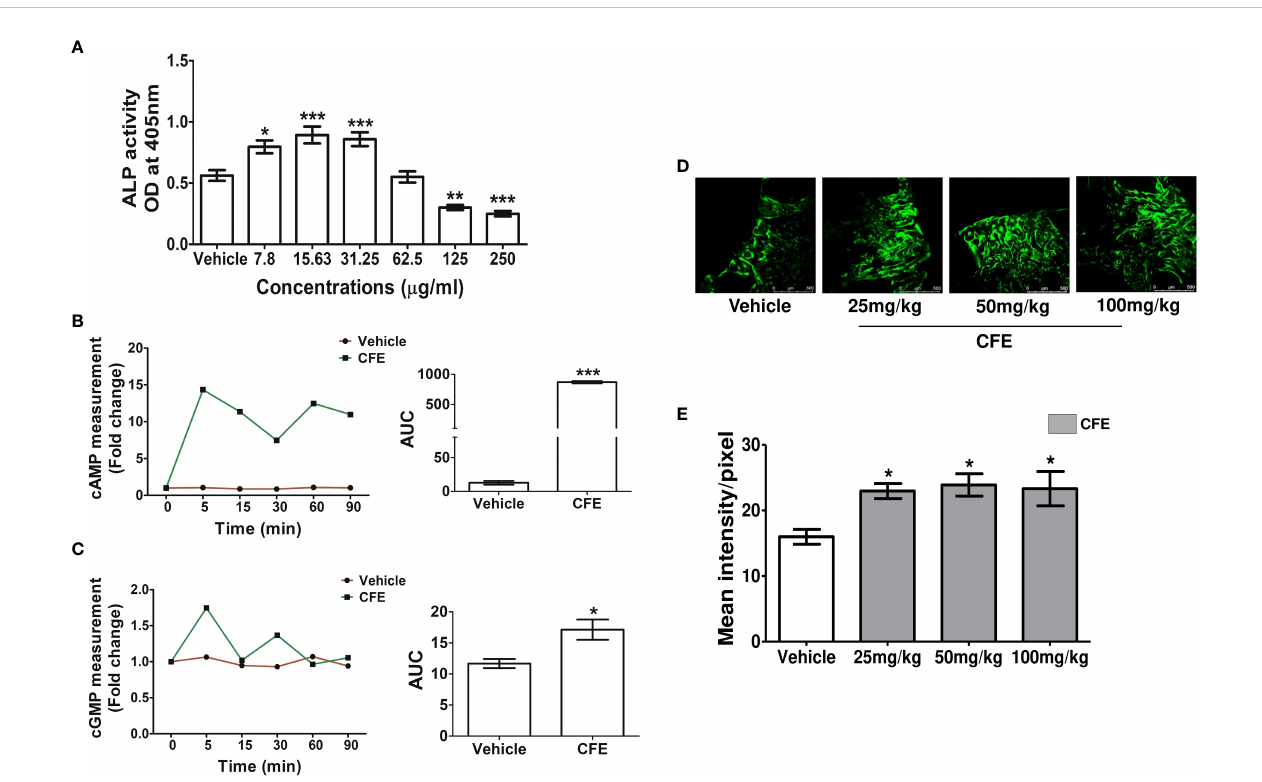
FIGURE 1 CFE stimulated osteoblast differentiation, cAMP and cGMP in vitro and promoted bone regeneration at the femur osteotomy site. (A) RCO were treated with CFE, and differentiation was assessed by ALP assay. (B) RCO were treated with CFE at the indicated time points and cAMP and (C) cGMP production were measured. (D) Adult female rats were treated with vehicle and CFE at indicated doses after femur osteotomy for 12 days, and representative images (10X) of calcein deposition at the osteotomy site are shown. (E) Quanti fi cation of the calcein deposition data are presented (n = 6 bones/group). All data are expressed as mean ± SEM; *p < 0.05, **p < 0.01, ***p<0.001 vs.